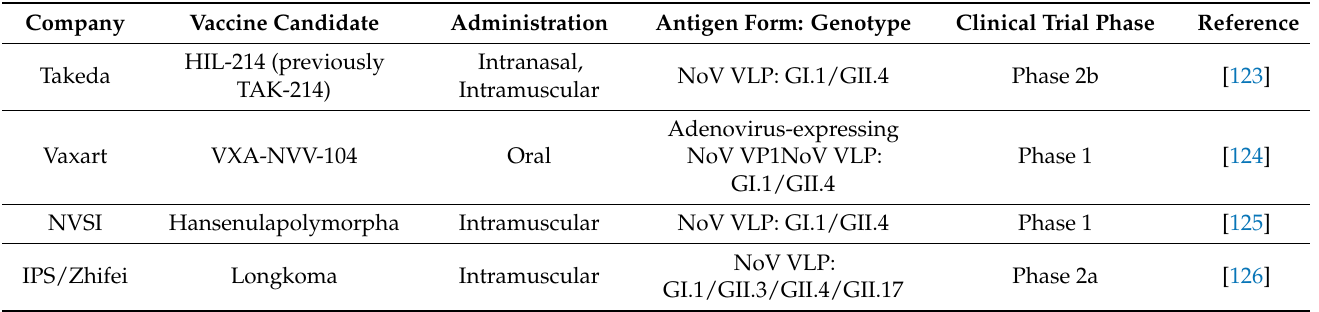
Table 3. NoV Vaccine